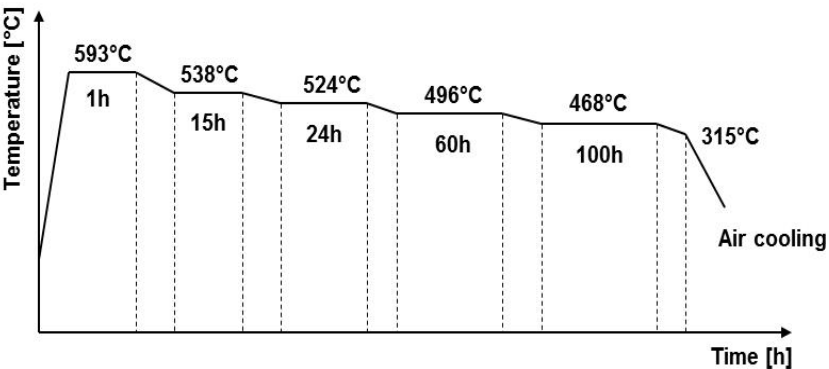
Figure 1. Step cooling heat treatment carried out on the investigated superclean steel.